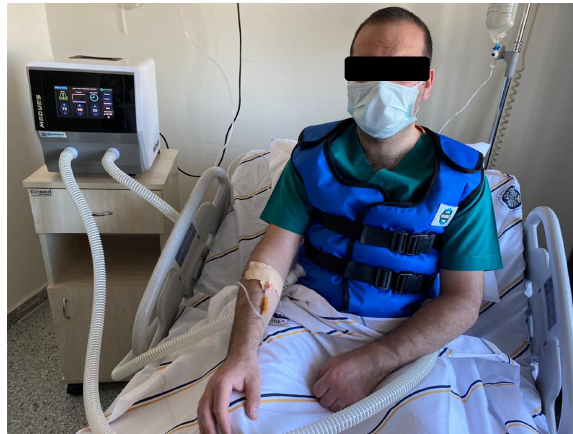
Figure 1. Application of high-frequency chest wall